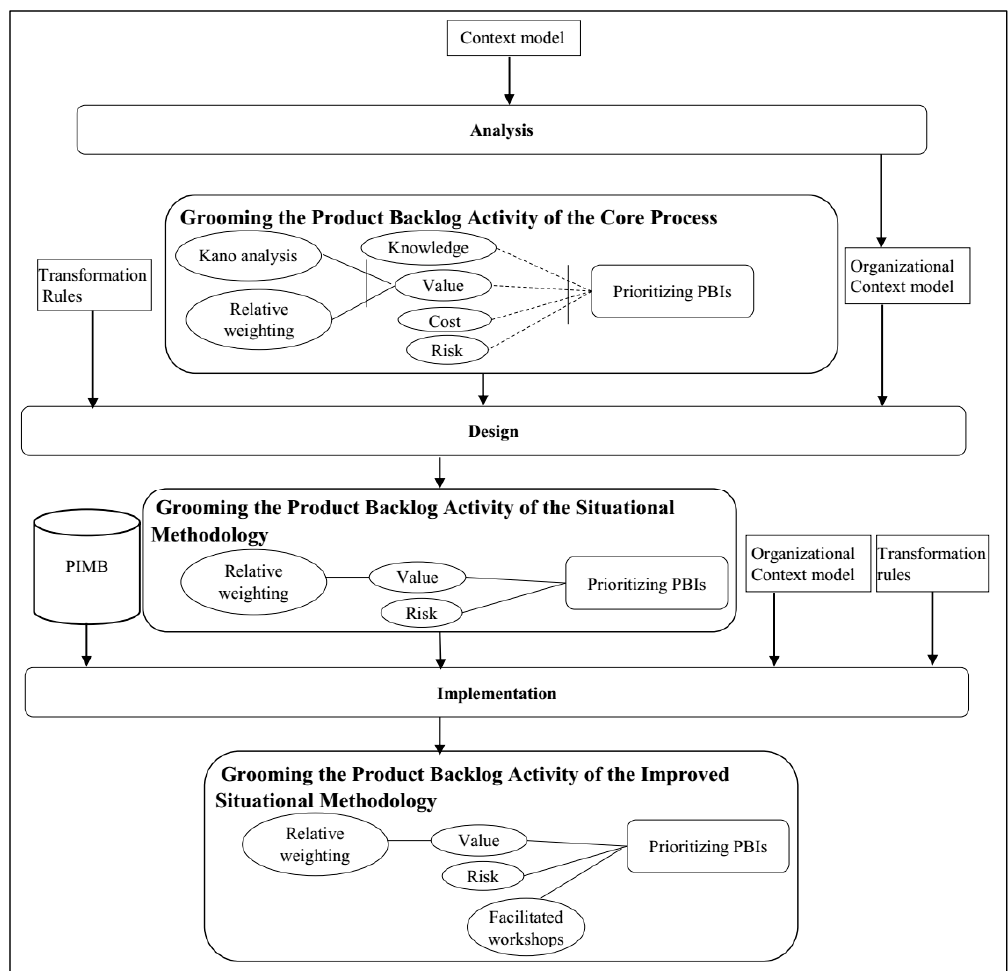
Figure A8. Examples of work products of AE subphases.